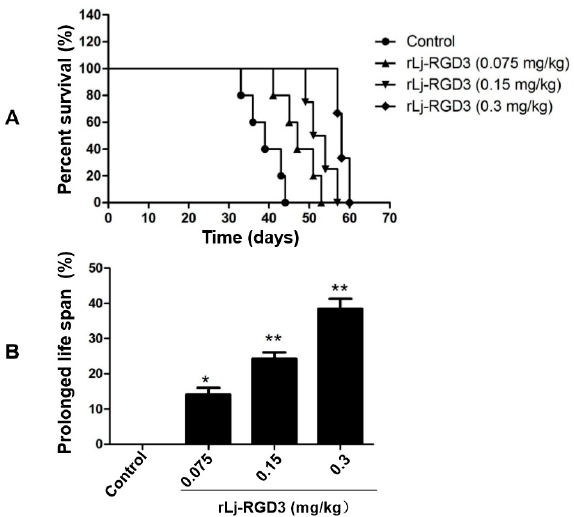
Figure 4 . rLj-RGD3 prolonged the survival days in HeyA8 xenografted mice ( n = 7). The survival plot for tumor-bearing mice treated with normal saline or rLj-RGD3 was shown in panel A. The prolonged life span was shown in panel B. Relative to the control group: * p < 0.05; ** p < 0.01.